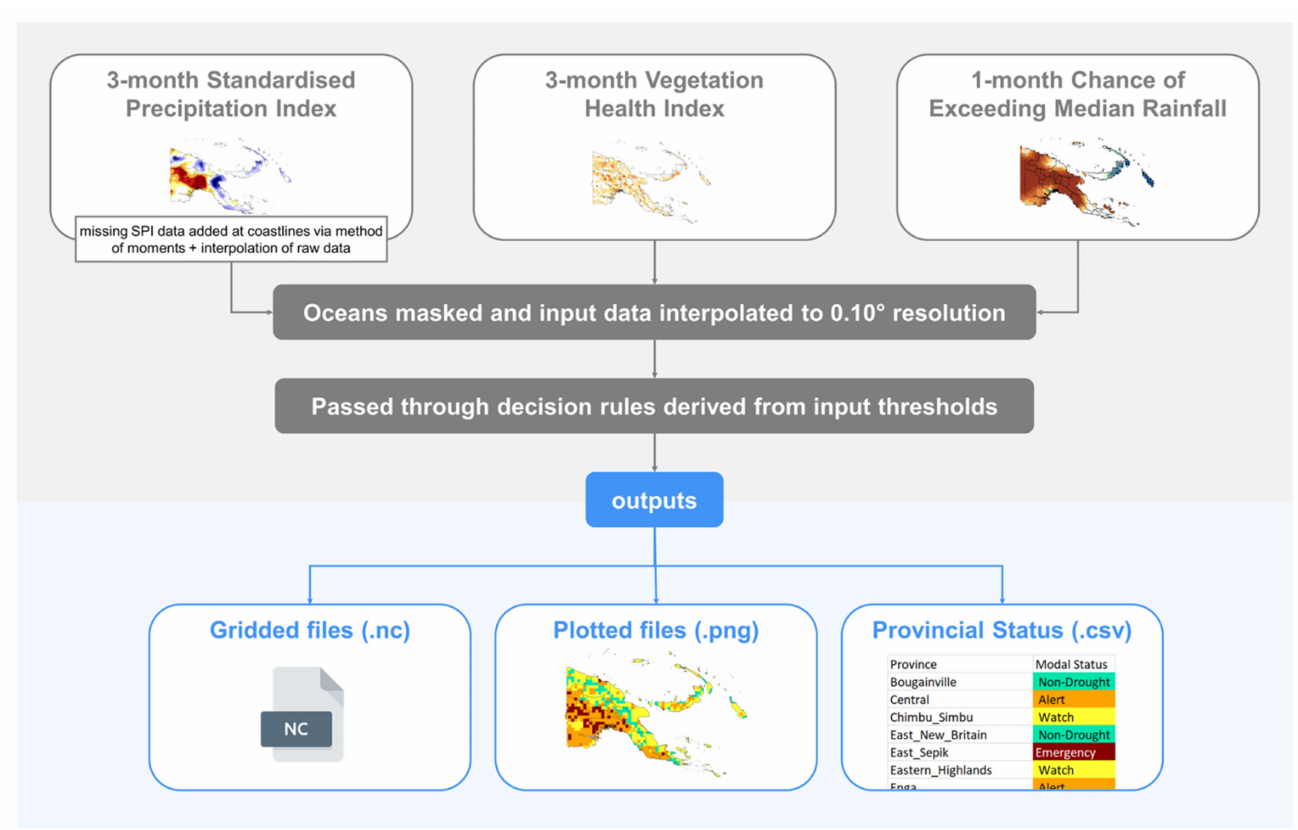
Figure 3. Workflow diagram of the drought I-EWS in this